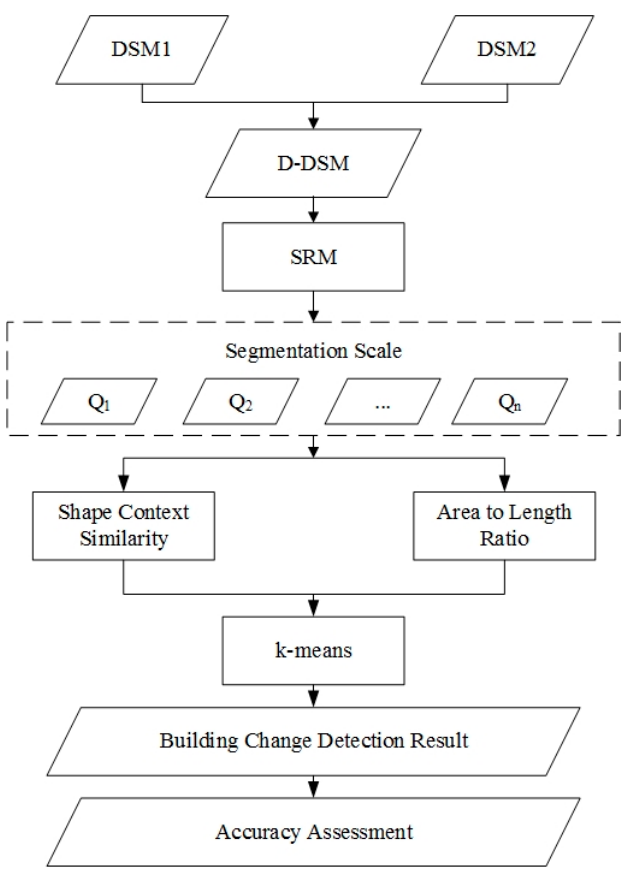
Figure 2. Schedule of proposed method.